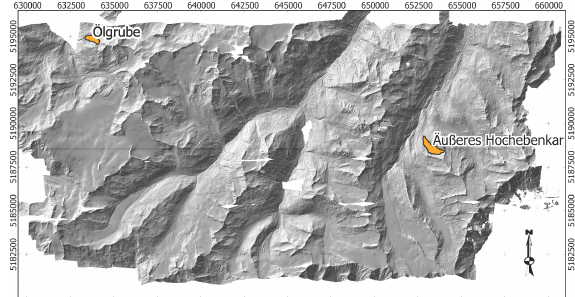
Figure 1: Shaded relief of the project area, derived by means of the FWF data. The highlighted areas denote the rock glaciers of Äußeres Hochebenkar and Ölgrube which we will focus on in Section 4. Coordinates are given in UTM, Zone 32N.